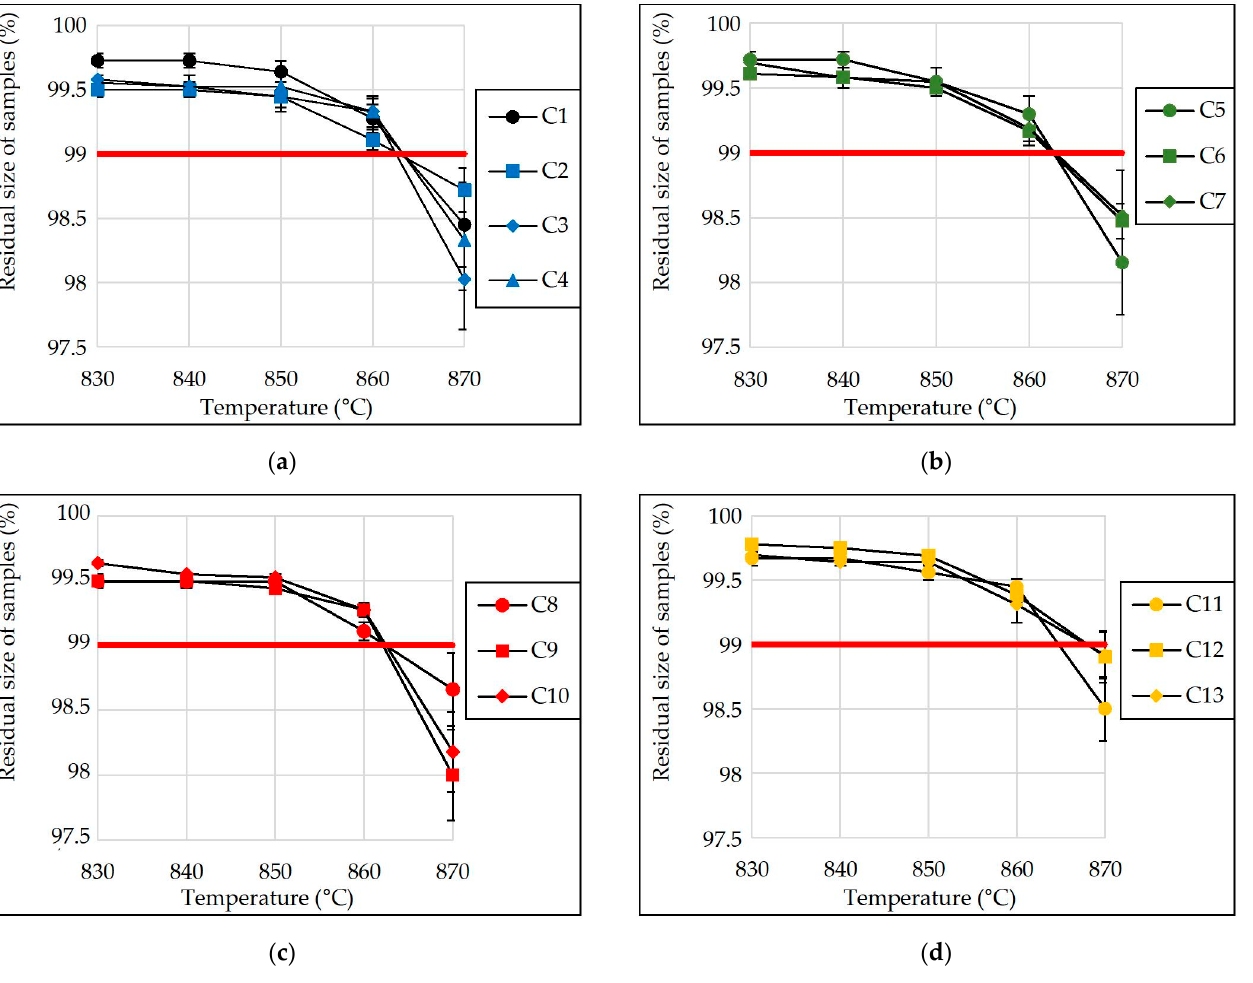
Figure 9. Residual size of samples after exposure to the set temperature for 2 h (samples from charge mixture containing: ( a ) no additive and with NaCl; ( b ) with KCl; ( c ) with MgCl 2 ·6H 2 O; ( d ) with CaCl 2 ; C1–C1 3 —numbers of compositions).